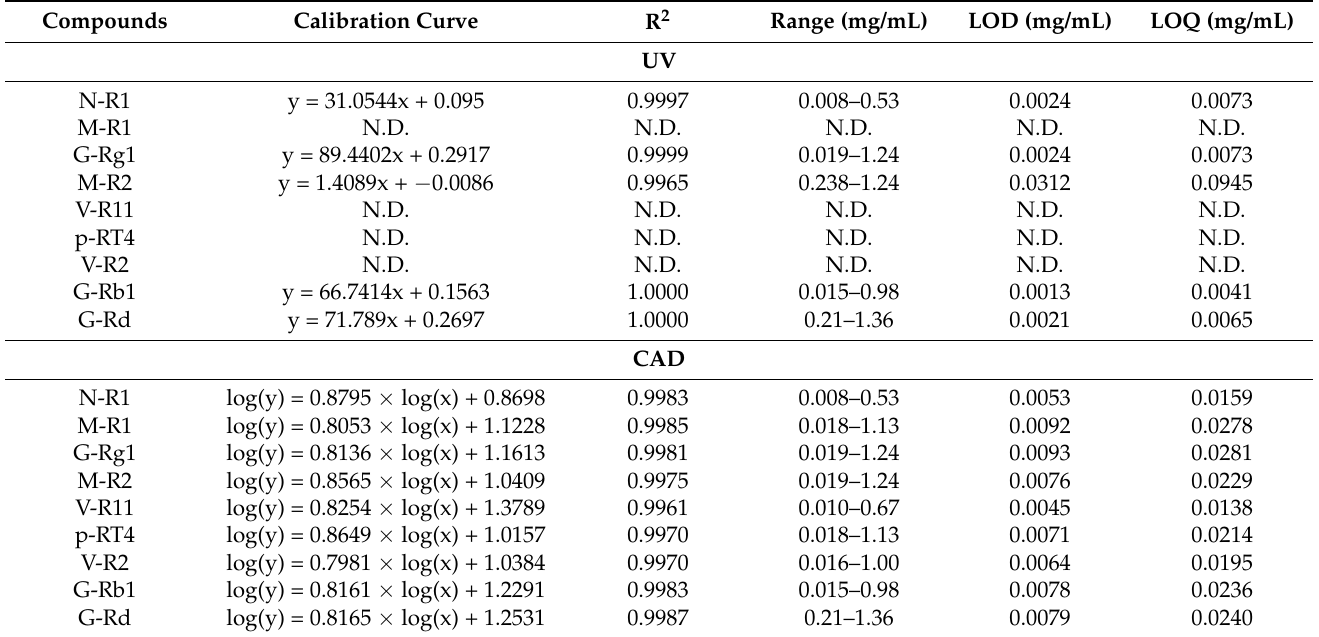
Table 1. Calibration curve, concentration range, LOD, and LOQ of nine